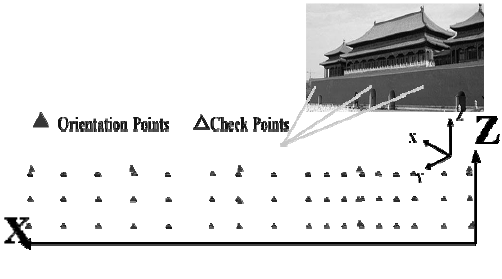
Figure6. The distribution of control points